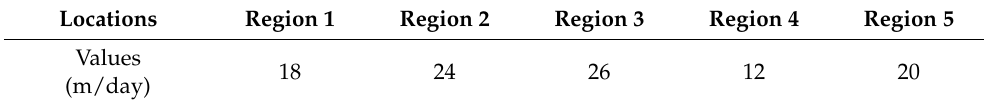
Table 3. The hydraulic conductivities of the